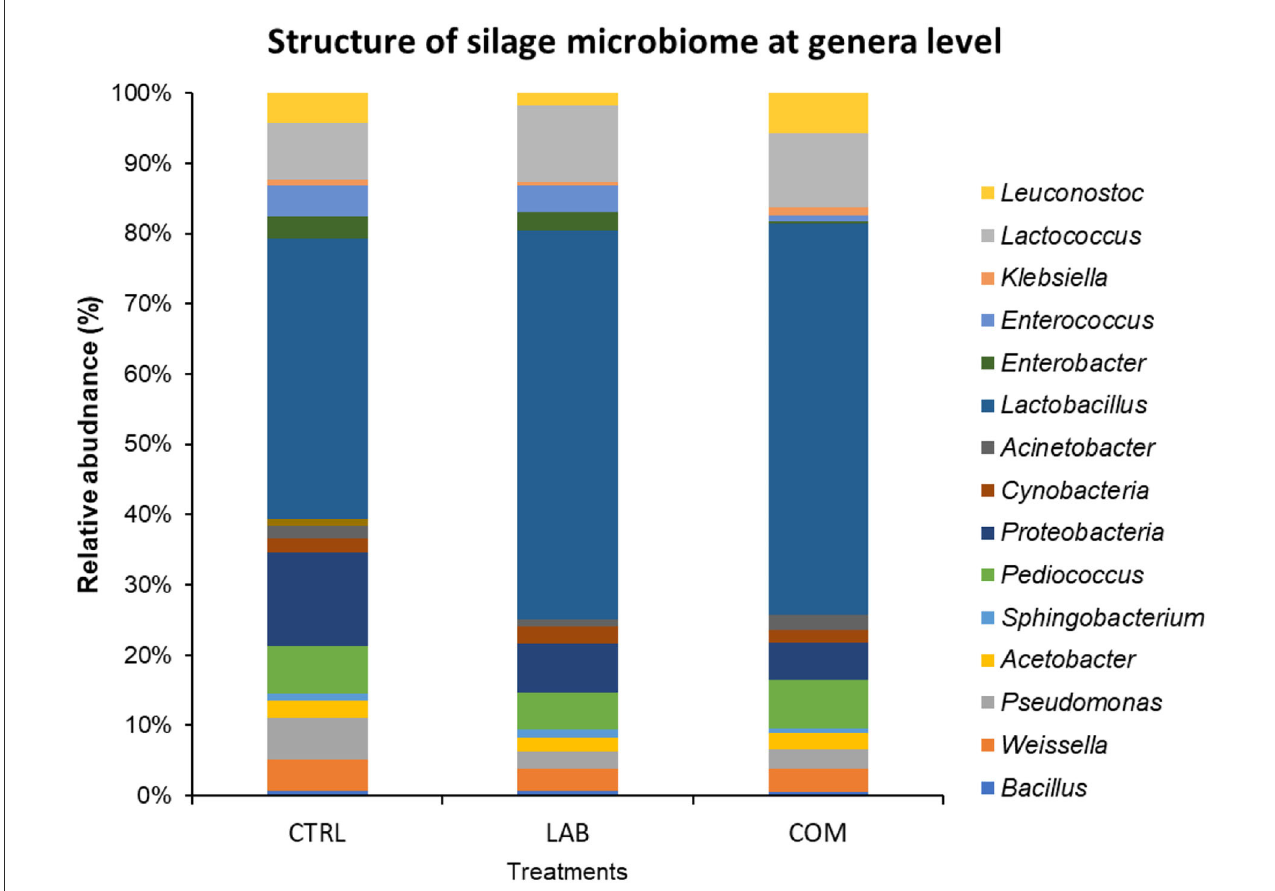
FIGURE1 Comparison structure of silage microbiome at genera level between control and inoculant addition.